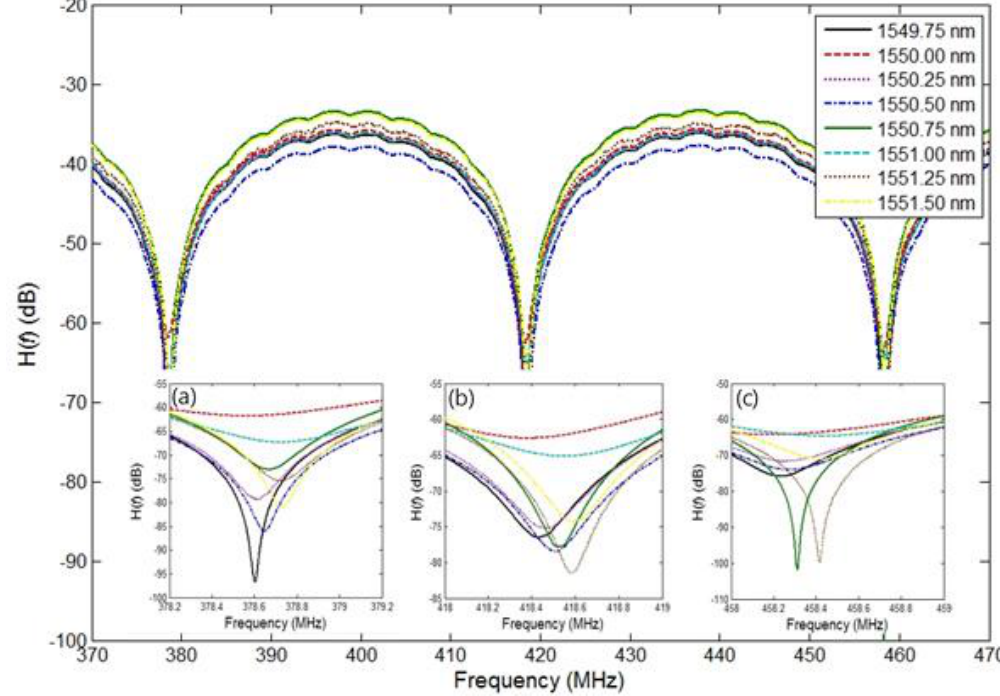
Figure 4. Measured transfer function H ( f ) for eight wavelengths (from 1,549.75 nm to 1,551.50 nm in 0.25 nm steps) with